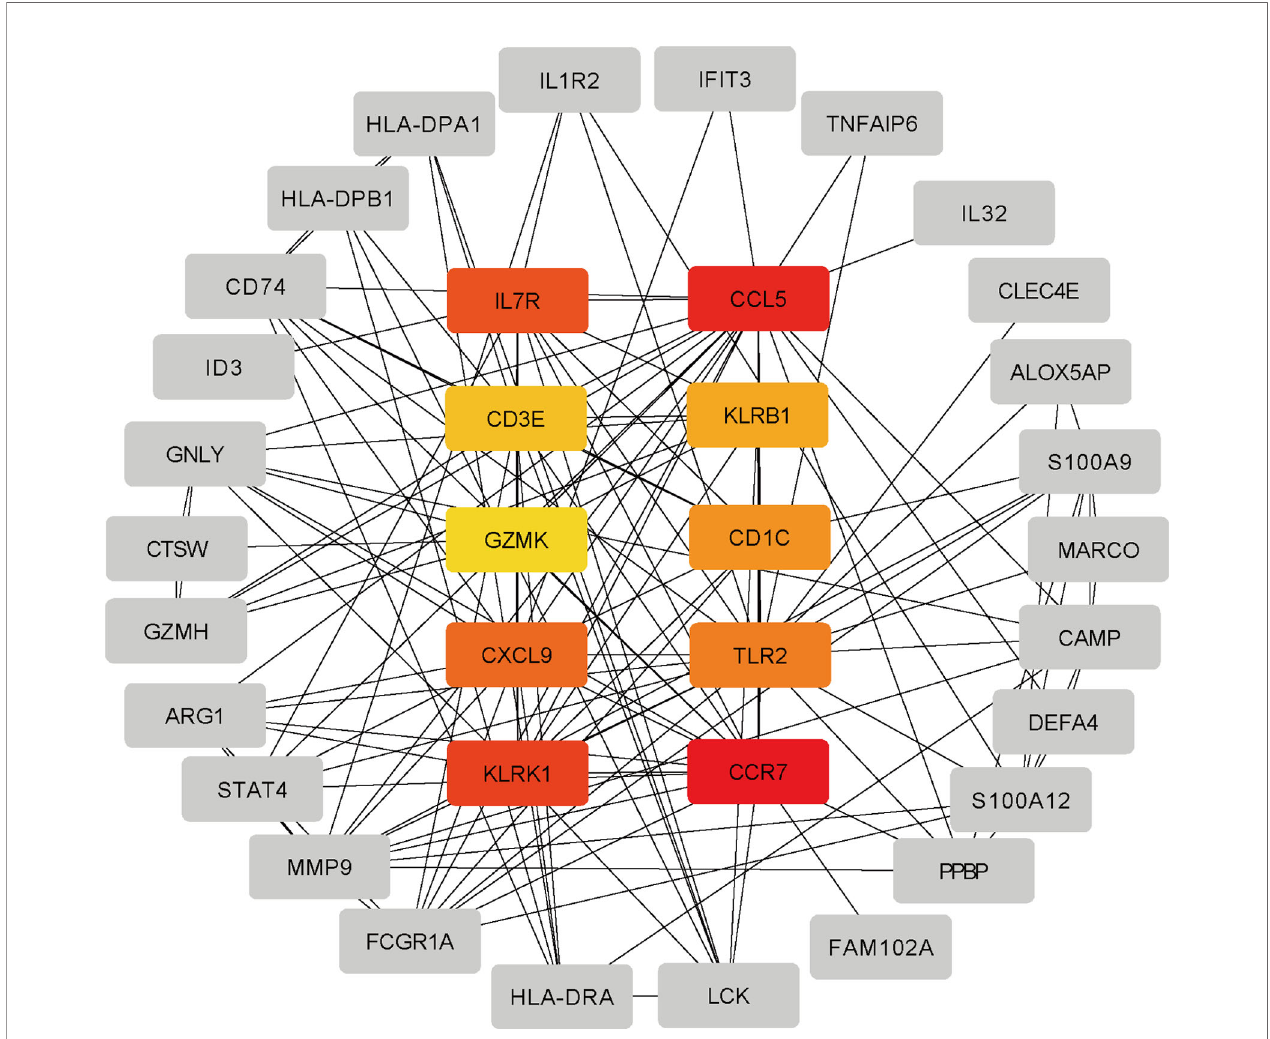
FIGURE 6 | The hub gene was identi fi ed from the PPI network using the Cytohubba plug in Cytosacpe. Here, the colored nodes represent the highlighted top 10 hub genes and their interactions with other